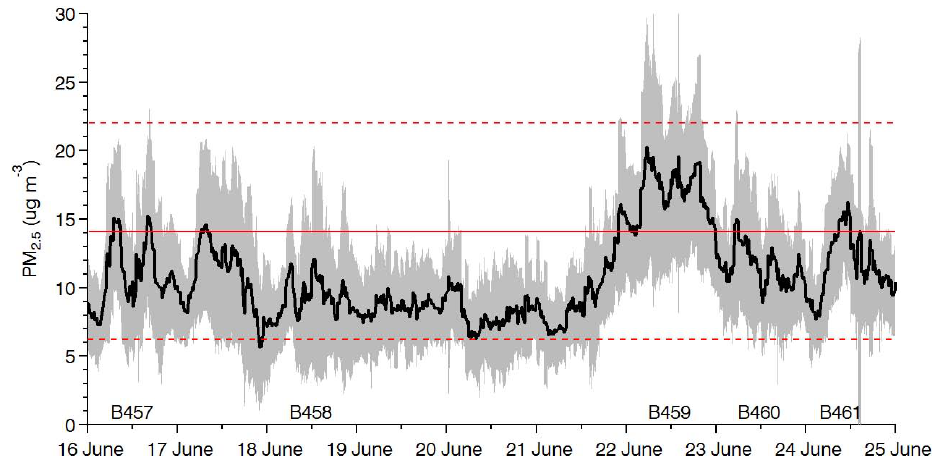
Fig. 3. Time series showing PM 2 . 5 concentrations during the EM25 campaign period in 2009. Heavy black line shows London average for all PM stations over the EM25 campaign and grey shading shows one standard deviation of the average. Solid red line shows the June/July historical London average PM 2 . 5 concentration from 2005 to 2009 (all station classifications) and dashed red lines show two standard deviations. Flight identification numbers indicate days when the FAAM BAe-146 research aircraft flew circuits over London. Date ticks are labelled at 00:00UTC for that day.